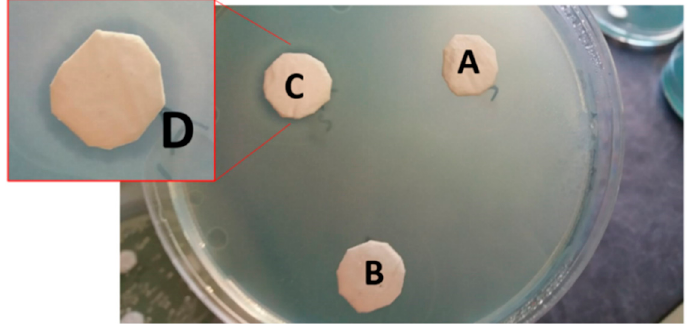
Figure 8. Modified Zone of Inhibition Test of P. aeruginosa after 24 h incubation with neutralized s-PBC@PP ( A ), PP ( B ), and standard s-PBC@PP ( C ) coupons spotted with 0.2 mL of sterile tap water. The clear zone around the standard s-PBC@PP coupon is shown in detail ( D ). Molecules 2020 , 25 , x